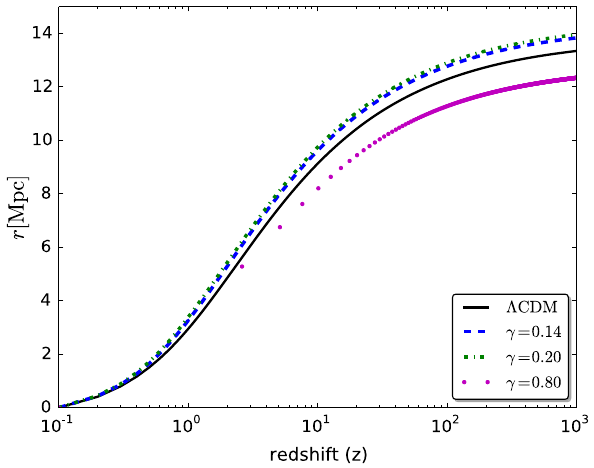
Fig. 5 The effect of the viscosity on the radial comoving distance in FRW metric. The other free parameters have been fixed by the SNIa observational constraint. The Λ CDM best fit is given by the Planck observation